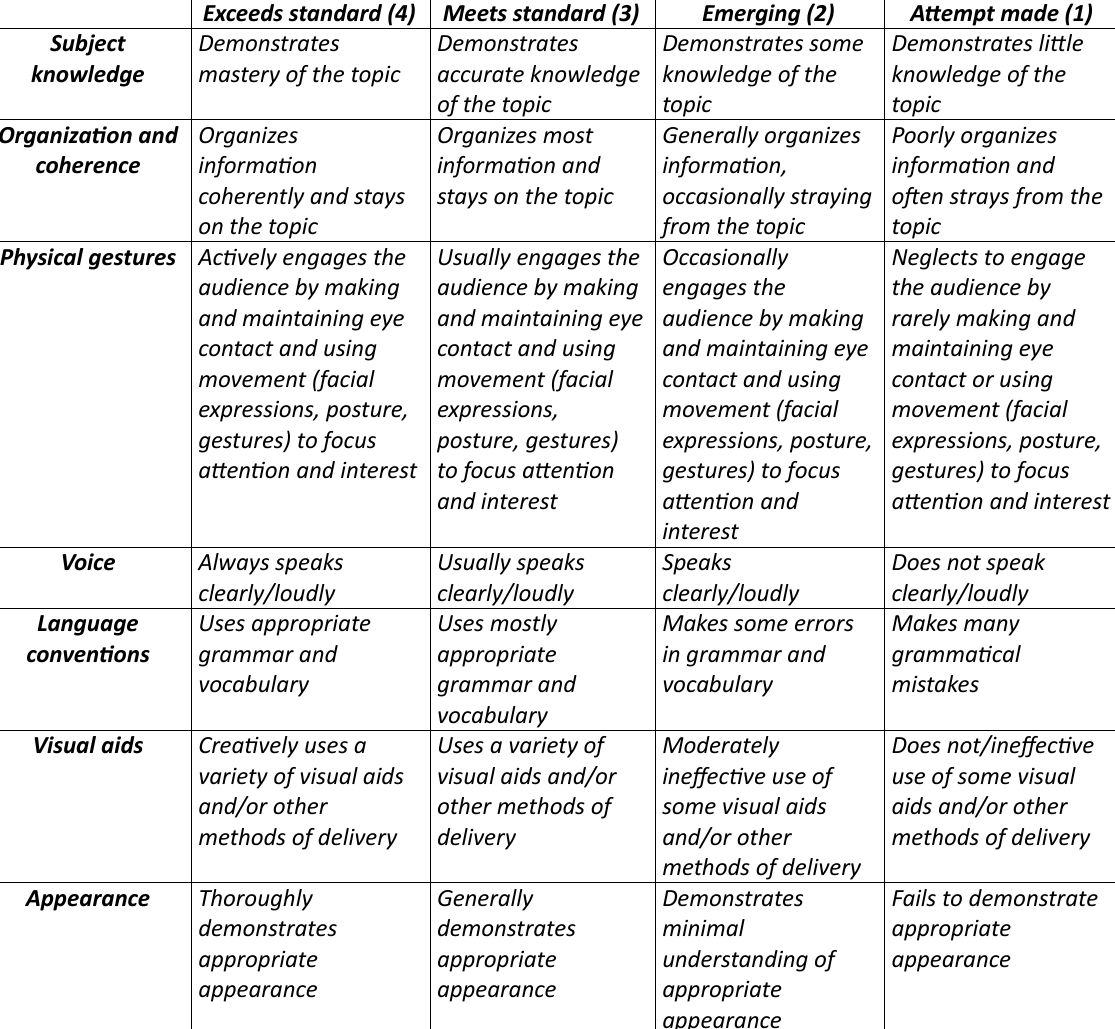
Table 5. Sample Presentaton Grading